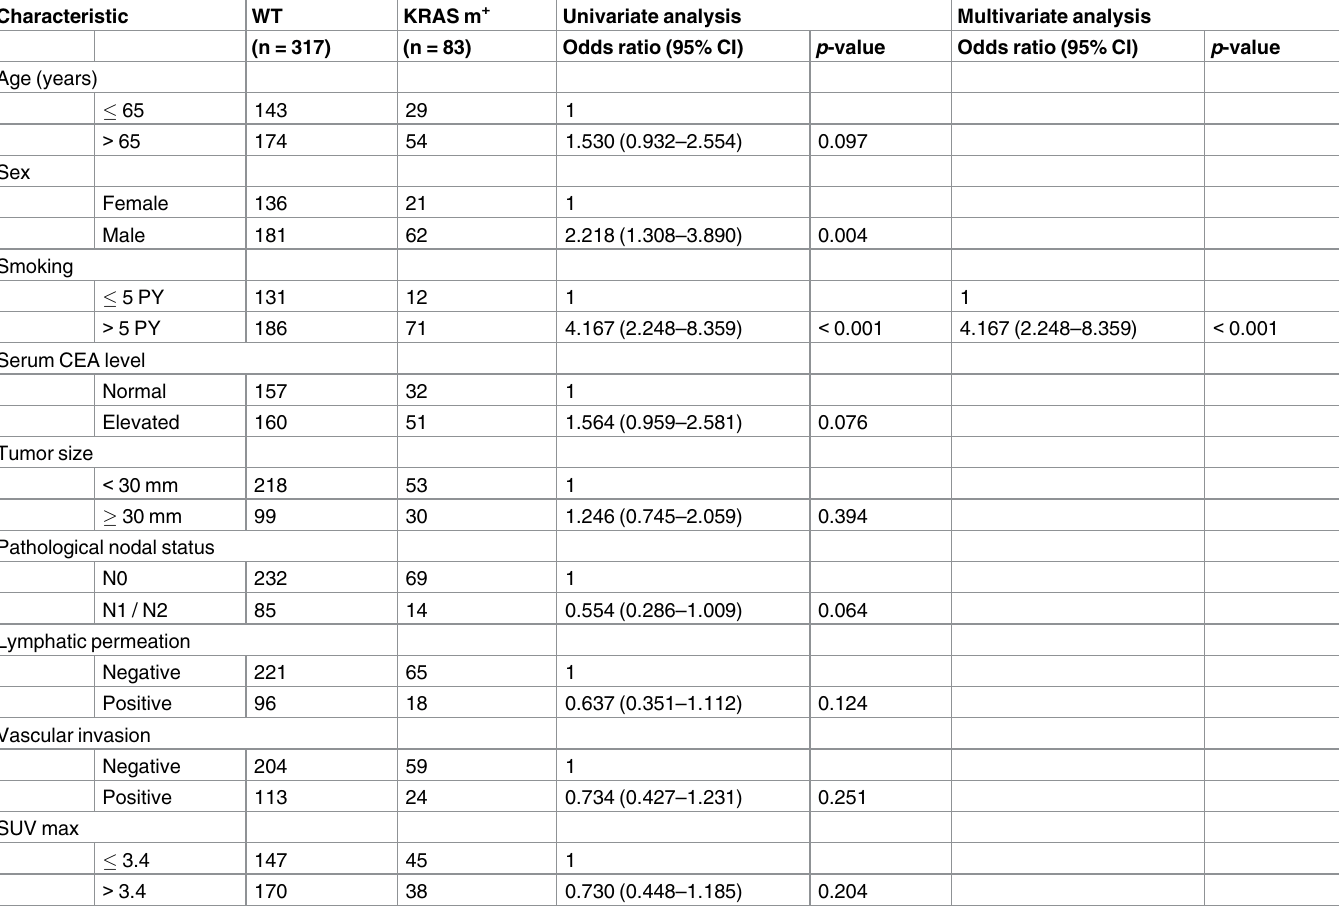
Table 3. Univariate and multivariate analysis of predictors of KRAS mutation. Characteristic